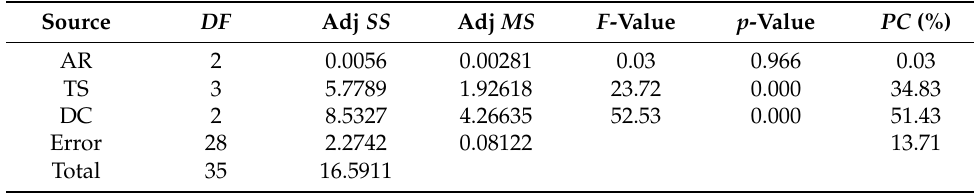
Table 7. ANOVA results for the 5 mm material